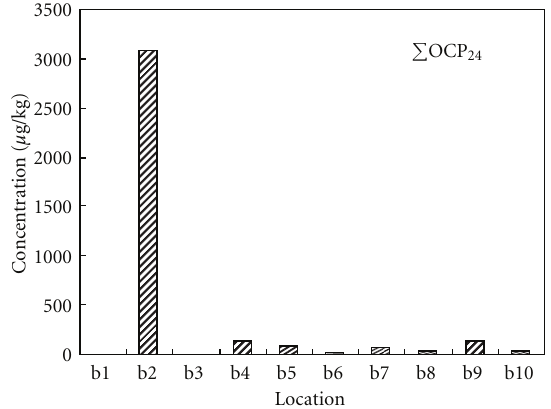
F 5: Concentrations of total PBDEs in the studied